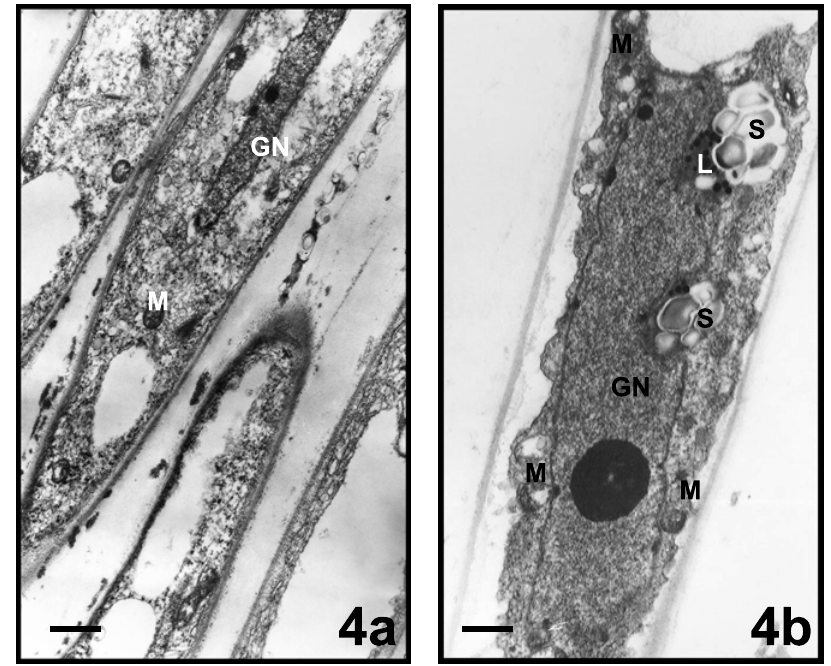
Fig. 4 – Nuclear zones (generative) of pollen tubes in Mimulus aurantiacus . a, bar = 1 μ m; b, bar = 750 nm. (GN, generative nucleus; L, lipid; M, mitochondria; S,